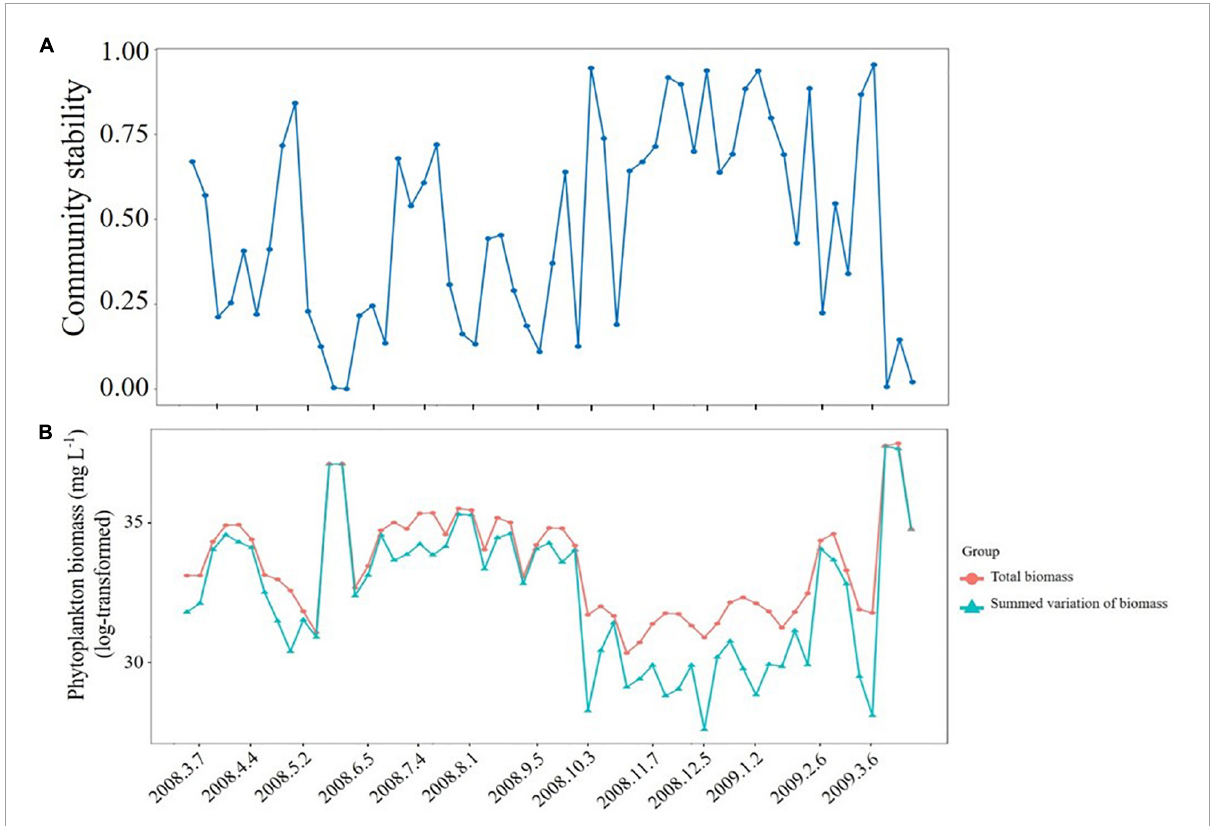
FIGURE2 Weekly dynamics of phytoplankton community stability (Bray–Curtis similarity) (A) and the components of Bray–Curtis similarity shown in panels (A,B) in the Xiangxi Bay of Three Gorges Reservoir